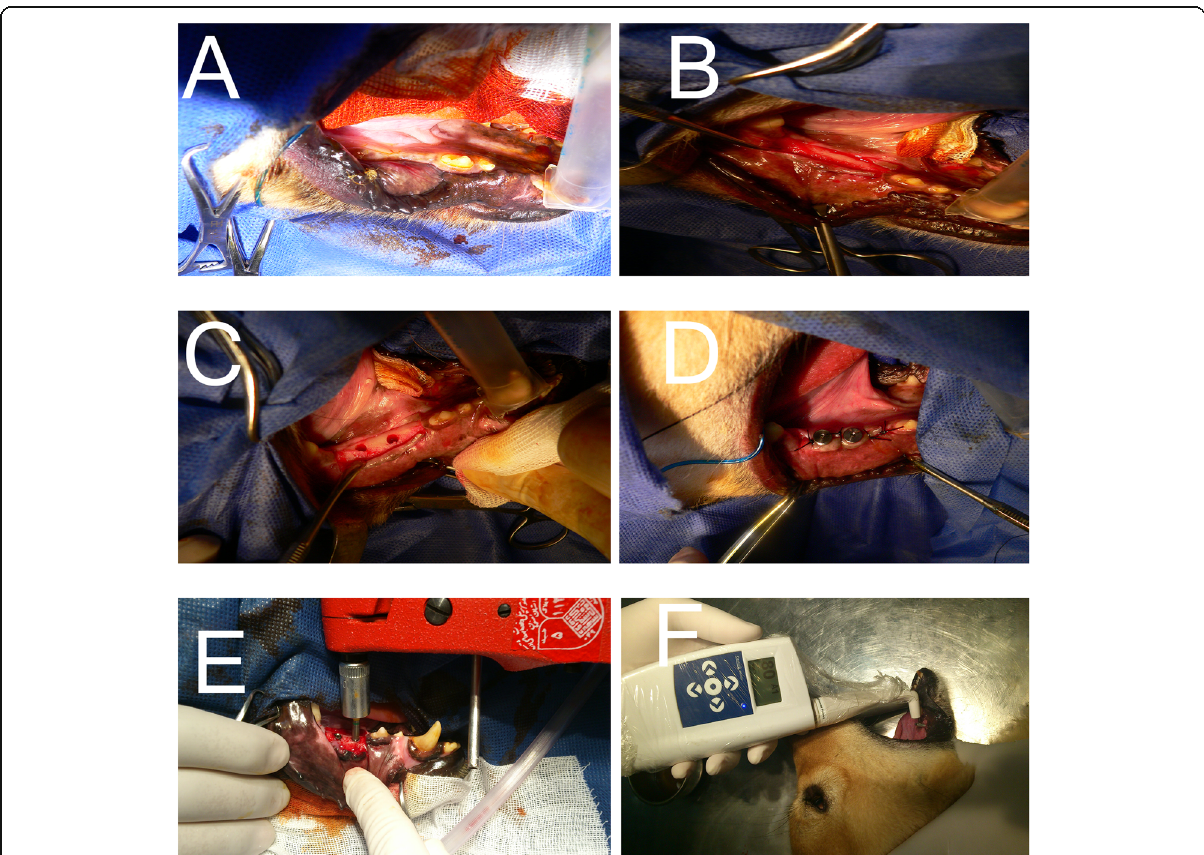
Fig. 2 Clinical view after 6 months of healing. Surgical exposure of the previous extraction site. Implant osteotomy preparation and implant placement. Torque value measurement and ISQ